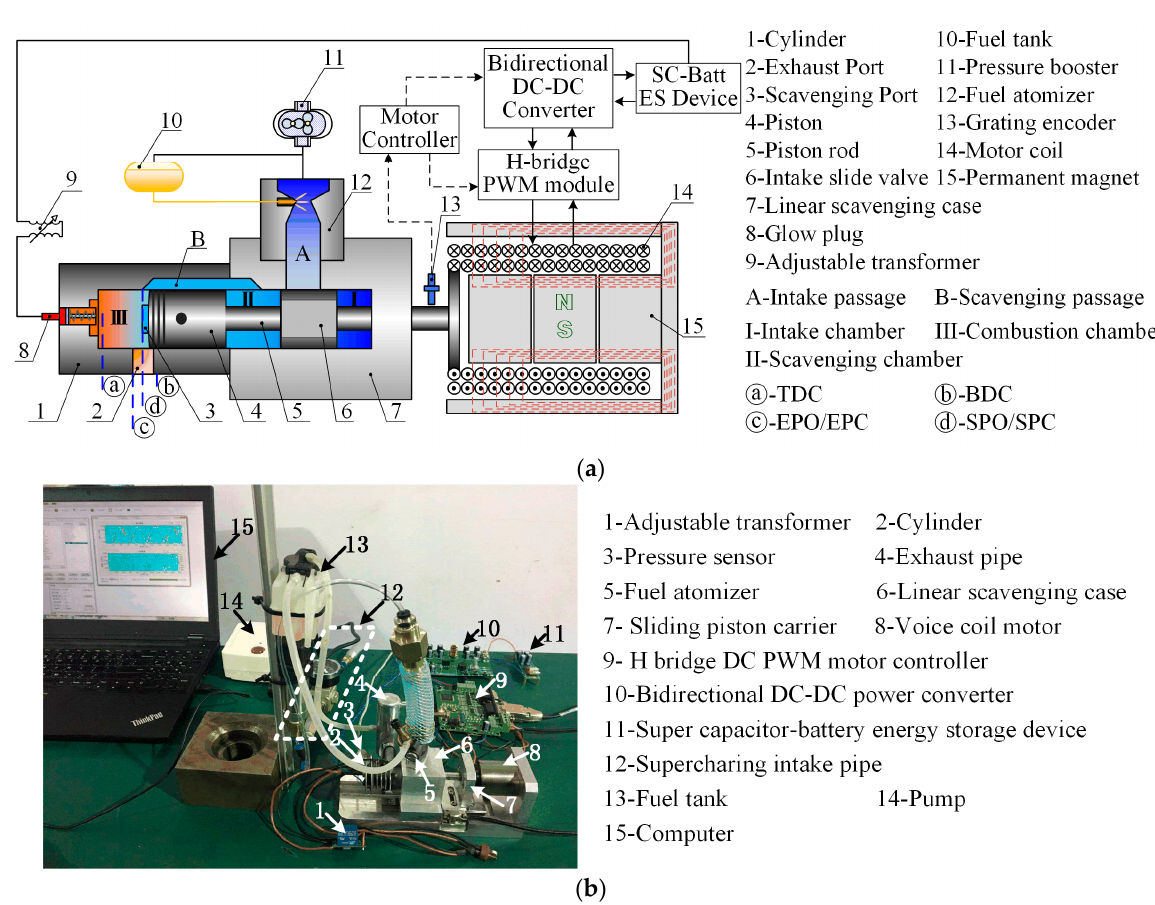
Figure 1. The miniature free-piston generator (MFPG) prototype. ( a ) The MFPG schematic diagram; ( b ) The MFPG test bench.